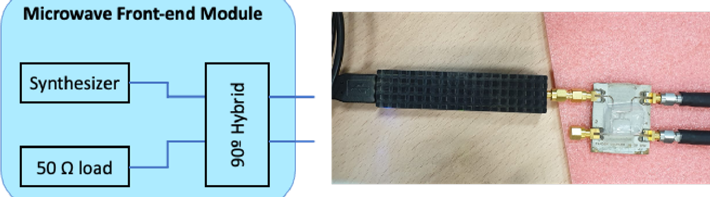
Figure 2. Block diagram of the front-end module used in the demonstrator. On the right, a scheme of the connected components is